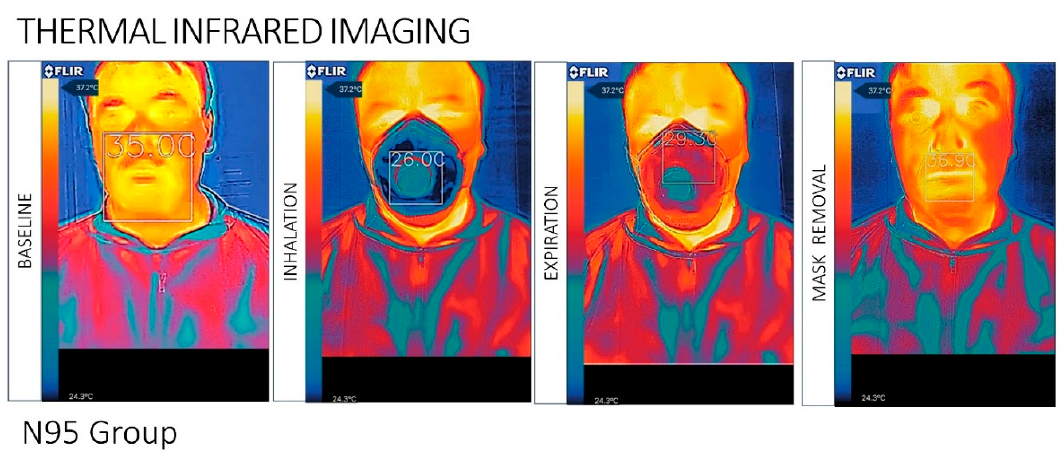
Figure 1. N95 mask group: The infrared images of facial skin temperature distributions associated with the use of a ventilation mask in male subject prior to applying the mask, with the mask applied, and after removal of the mask. The values specified on the thermal images are the local temperatures at the sites of interest (bridge of the nose, two cheeks, and chin), averaged in the respective marked regions (bounded by ellipses). All temperature values are in Celsius.